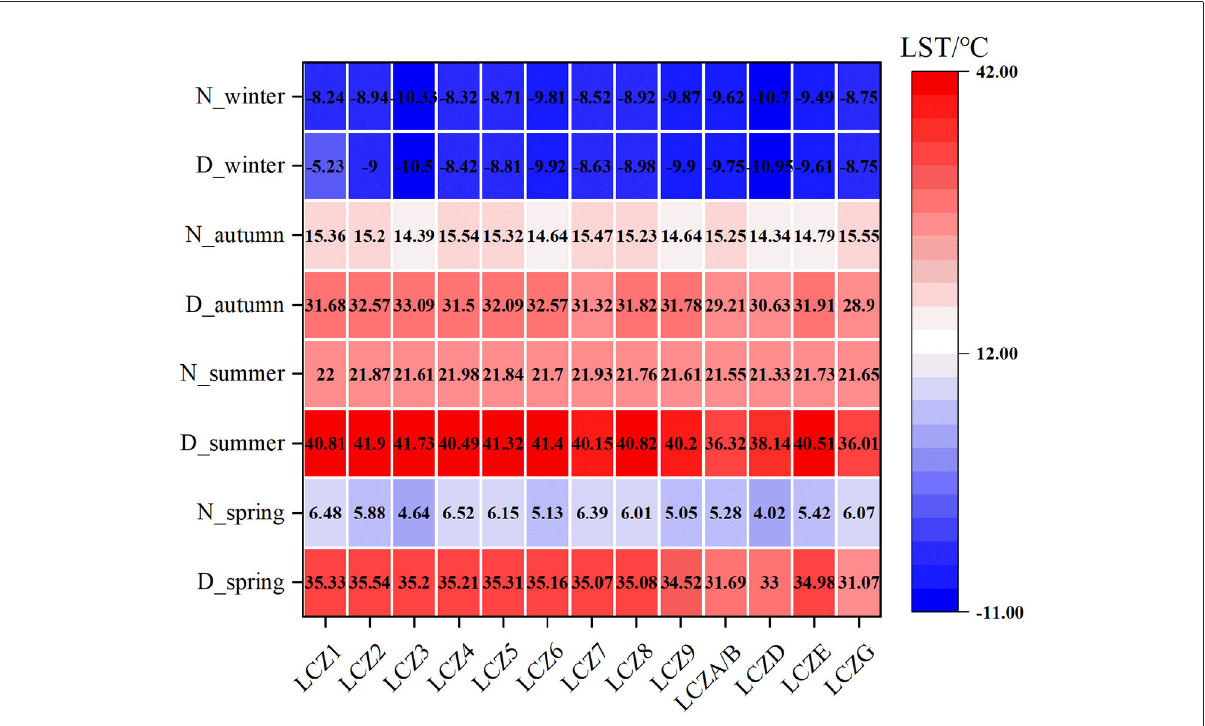
FIGURE7 Diurnal variation of the same LCZ in different